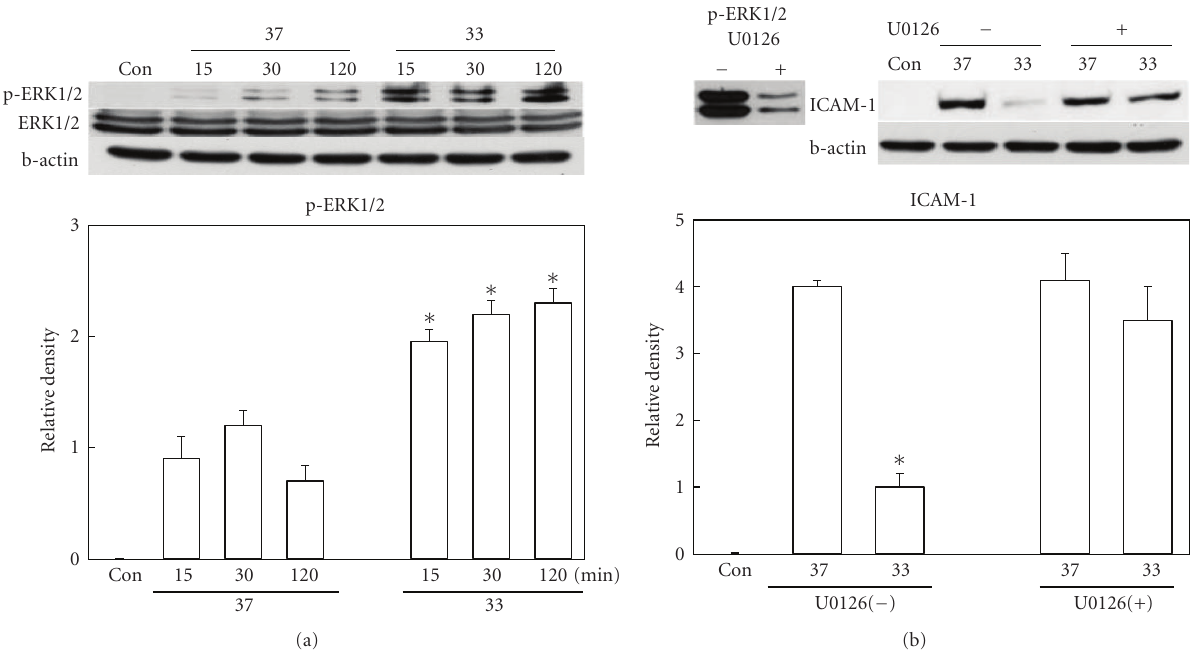
Figure 2: Western blot analysis of phosphorylated ERK1/2 and ICAM-1. (a) Phosphorylation of ERK1/2 was significantly higher in hypothermic (33) brains than normothermic (37) ones at 15, 30, and 120 minutes after ischemic insult ( n = 6 per group). Total ERK1/2 level was not changed. (b) Ischemia-induced increase of ICAM-1 at 24 hours after MCAO was suppressed by hypothermia. But this suppression was not observed when ERK1/2 inhibition was done (U0126, n = 4) at the dose which almost completely inhibited ERK1/2 phosphorylation. ∗ P < . 05 versus